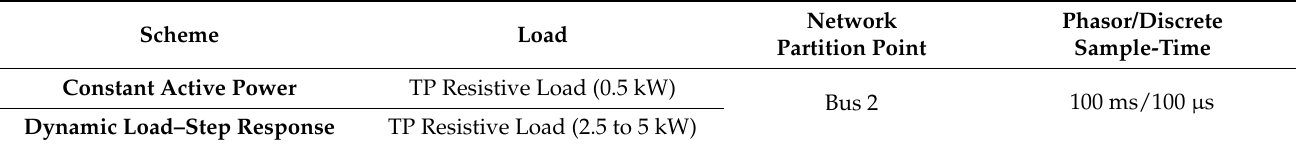
Table 1. Offline hybrid simulation scenarios to assess the functioning of the hybrid model.